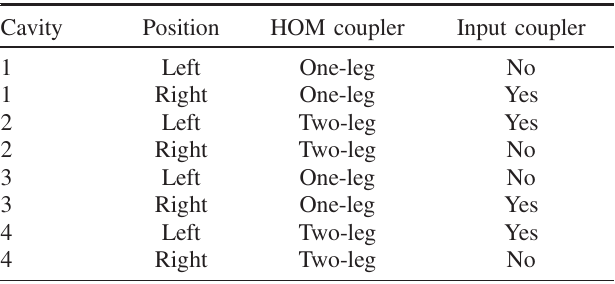
TABLE I. List of coupler types attached to the cavities in the ACC39 chain.